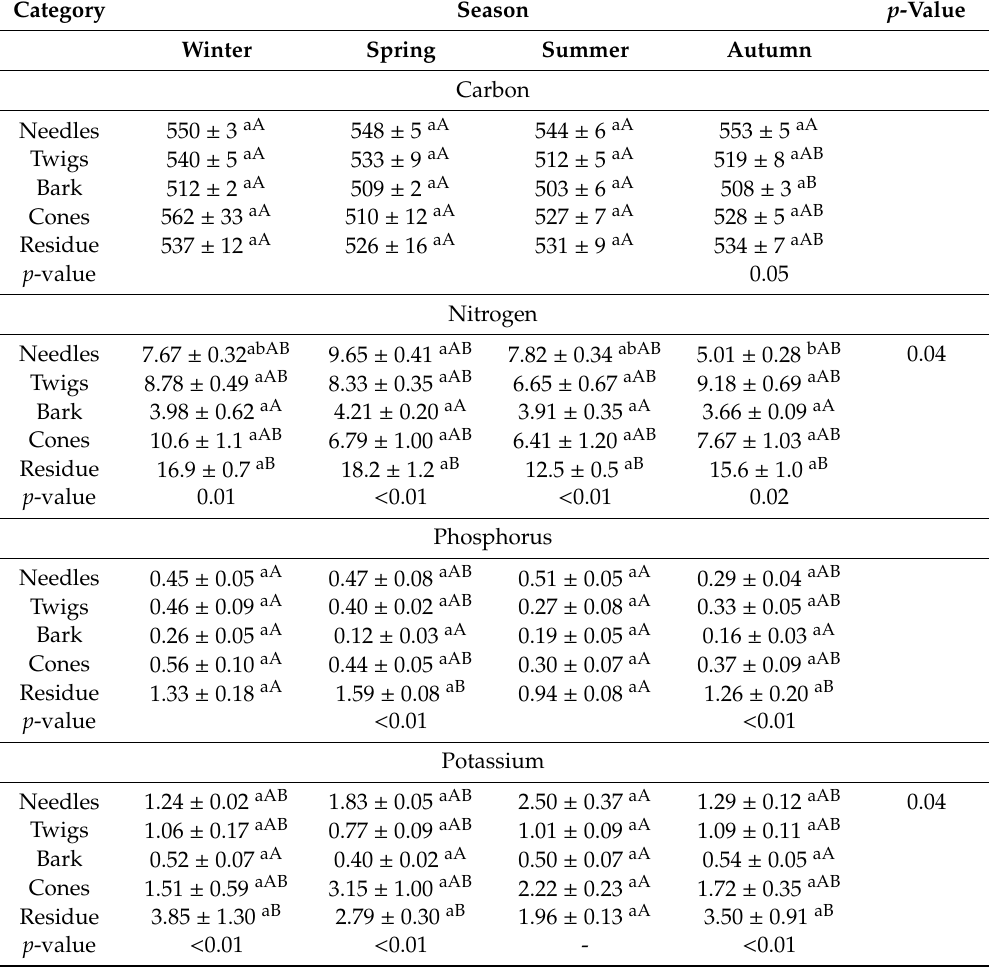
Table 2. Mean contents ( ± SE) of elements in the litterfall categories by season (g kg − 1 ) on slope N. p -values were obtained after the Kruskal–Wallis test: values in rows refer to di ff erences in content of an element between litterfall categories in a season; values in the last column refer to di ff erences in content of an element between seasons in a litterfall category (only values of p < 0.05 were shown); lower cases at the SE values refer to rows (di ff erent letters indicate the di ff erence in the element content between seasons), while capital letters at the SE values refer to columns (di ff erent letters indicate the di ff erence in the element content between litterfall